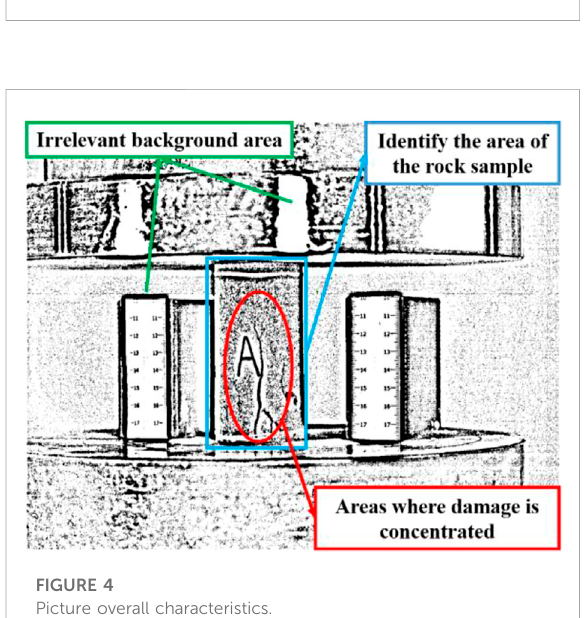
FIGURE 3 Method fl owchart.